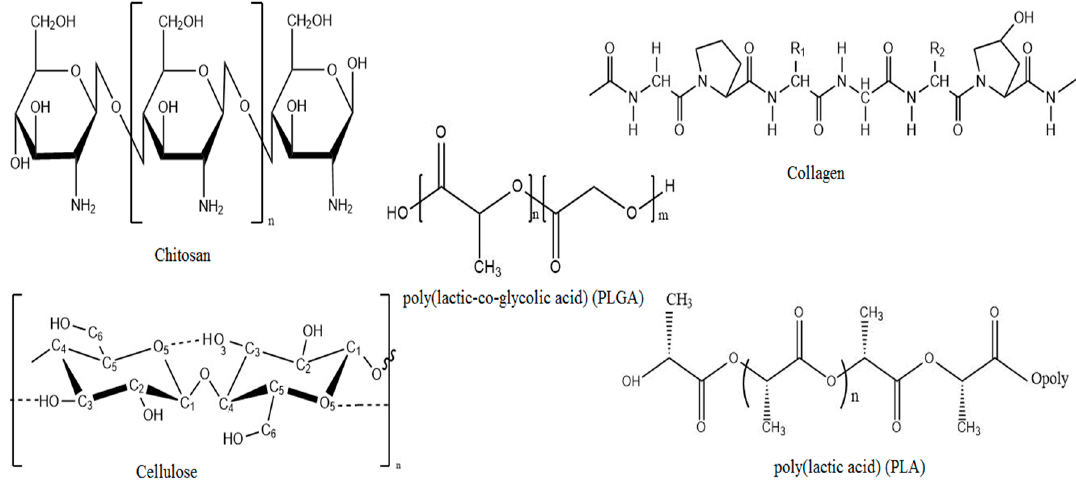
Figure 7. Chemical structures of biopolymers commonly used in the preparation of porous biomaterials.